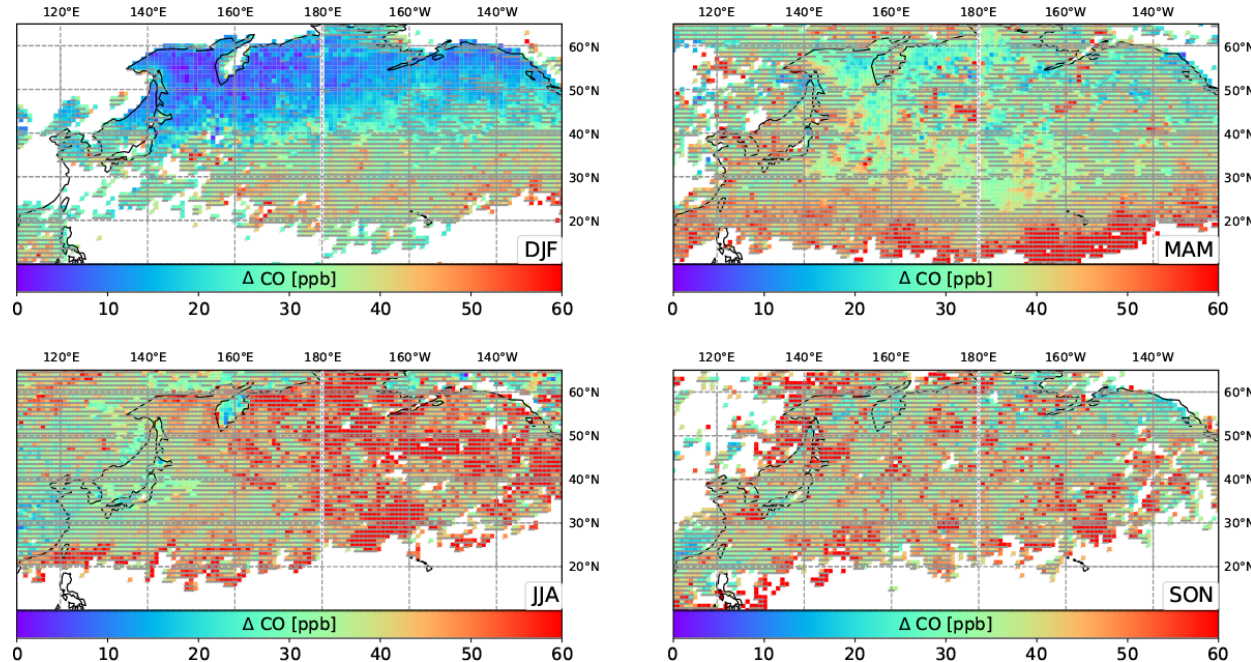
Figure 2. Difference [ppb] between CO seasonal mean mixing ratios at 400hPa considering only CO maxima events and total seasonal mean CO mixing ratios including all valid data points (2000–2019). Grid points marked by grey crosses show a difference with a strong statistical significance (regions where the pooled standard deviation is within the 99% confidence interval).